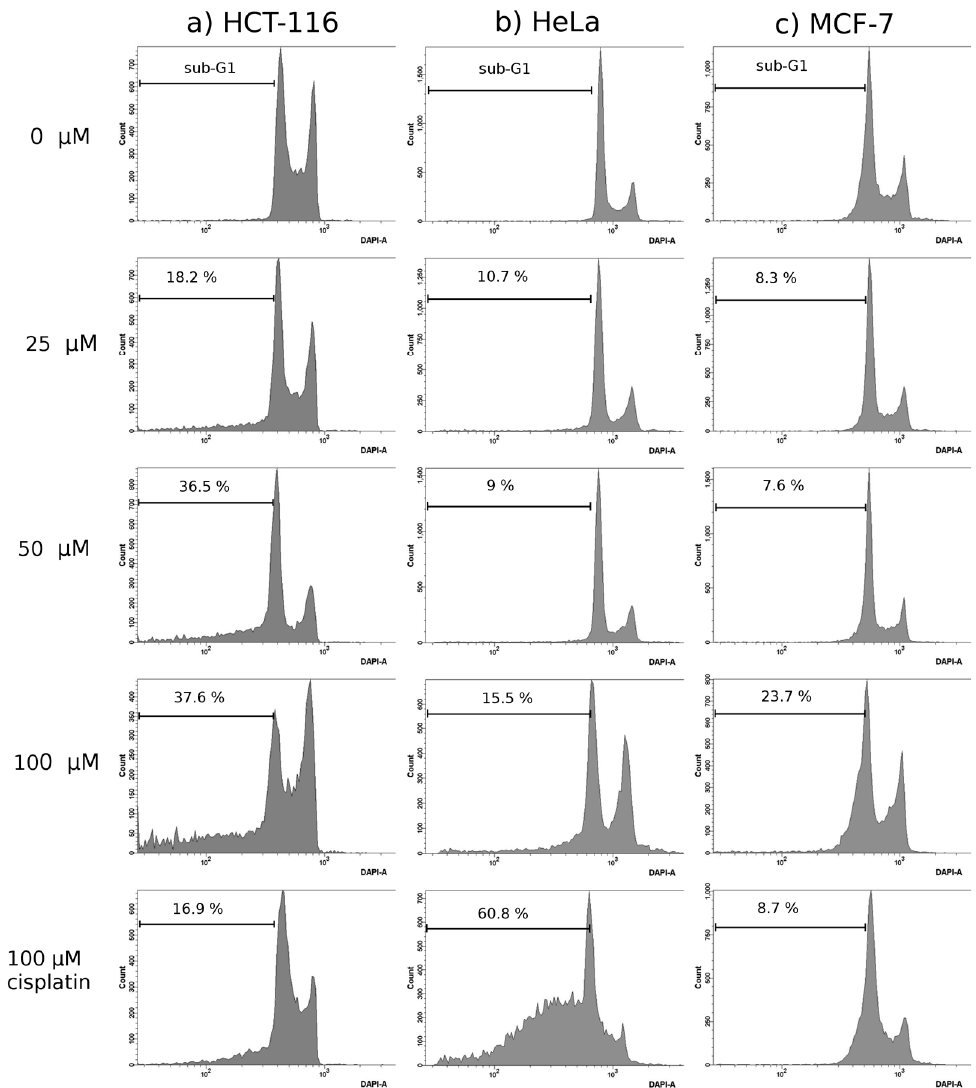
Figure 4. HCT-116, HeLa and MCF-7 cell cycle 24 h induction with 1,2,4-triazine derivatives (representative results). HCT-116 ( a ); HeLa ( b ) treated with 37 (0–100 μ M) and cisplatin (100 μ M); MCF-7 ( c ) treated with 46 (0–100 μ M) and cisplatin (100 μ M). Mitochondrial Membrane Potential ( ∆ ψ m )